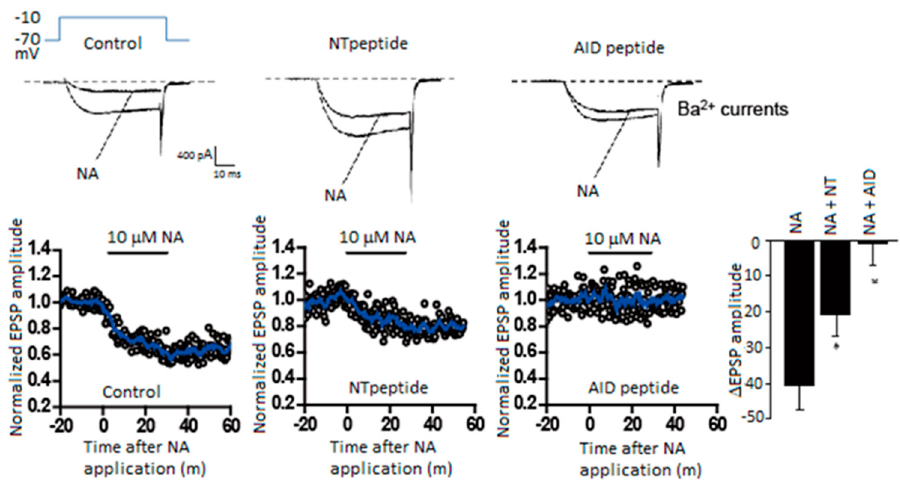
Figure 2. G βγ -mediated noradrenaline inhibition of transmitter release and N-terminal/I-II loop